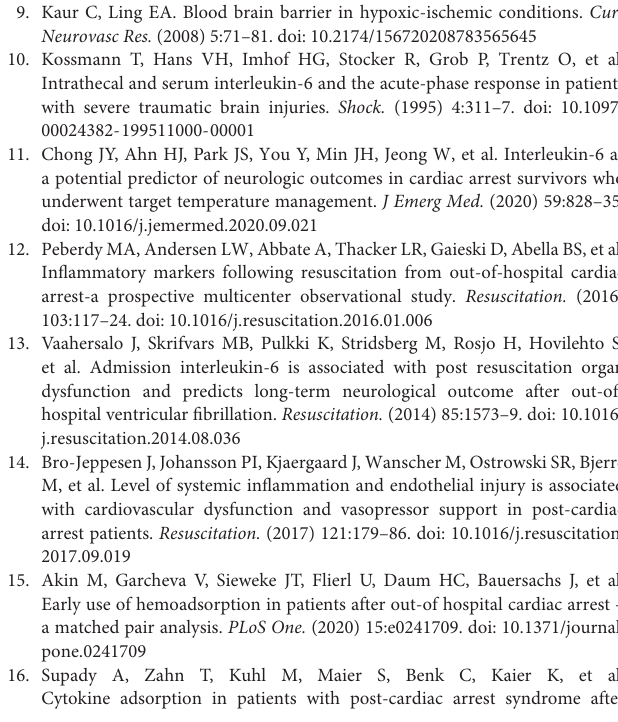
Supplementary Figure 1 | Flow chart of identified HACORE patients with OHCA in 2017–2020 and selection for further analyzed patient’s. Supplementary Figure 2 | Distribution of NSE (A,D) , S-100b (B,E) and lactate (C,F) according to 30-day survival (A–C) for survivors and non-survivors and according to neurological outcome (D–F) for patients with good (CPC ≤ 2) and poor outcome (CPC ≥ 3), respectively. Supplementary Figure 3 | Forest chart for univariate (A,C) and multivariate (B,D) analysis for 30-day survival (A,B) and poor neurological outcome (C,D)